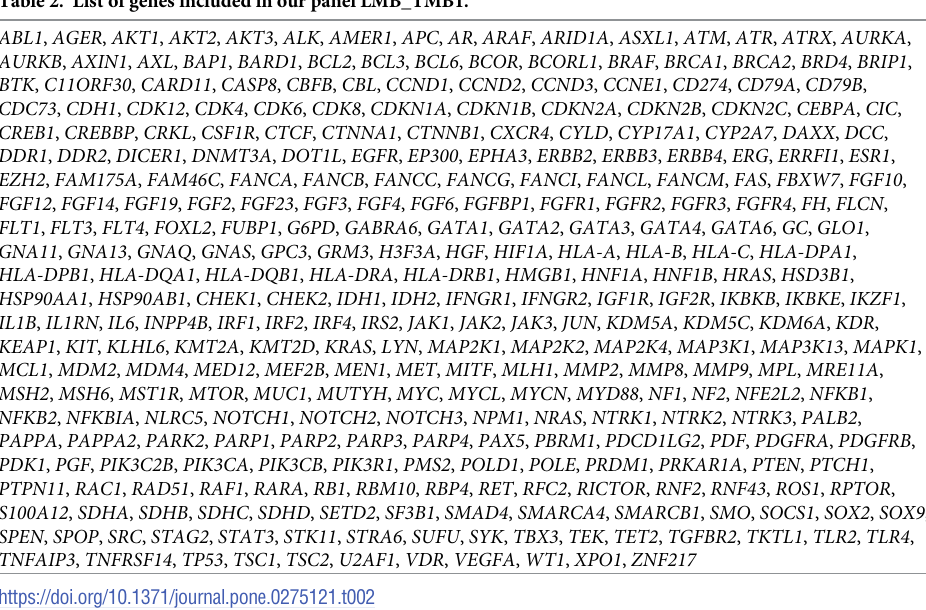
Table 2. List of genes included in our panel